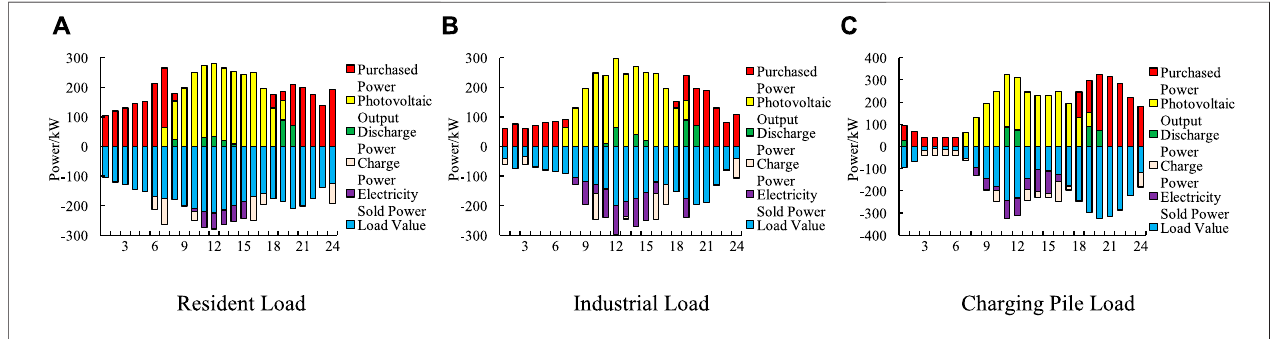
FIGURE 4 | Optimal scheduling outputs of units in Mode